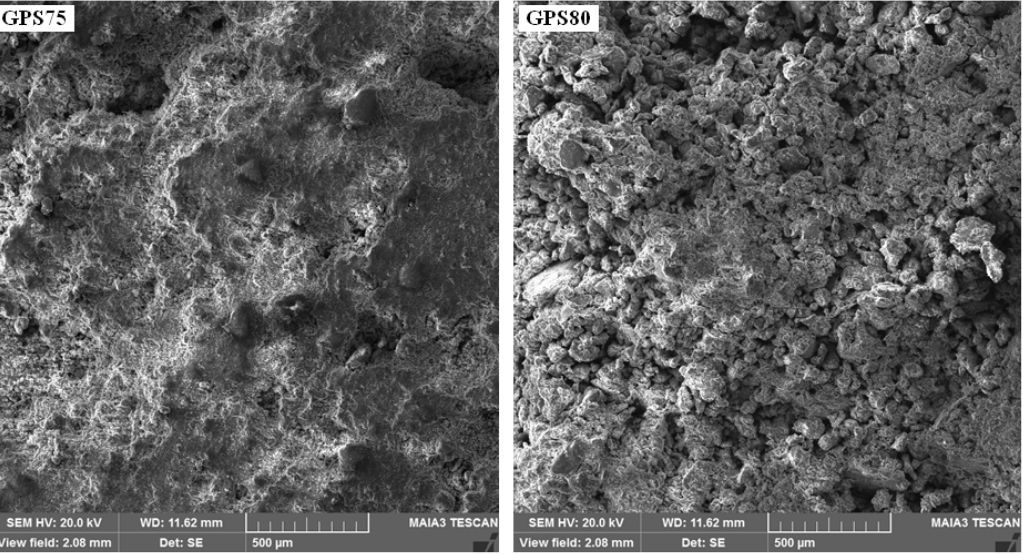
Figure 7. SEM images of GPS75 and GPS80 showing a continuous and agglomerated matrix, respectively.